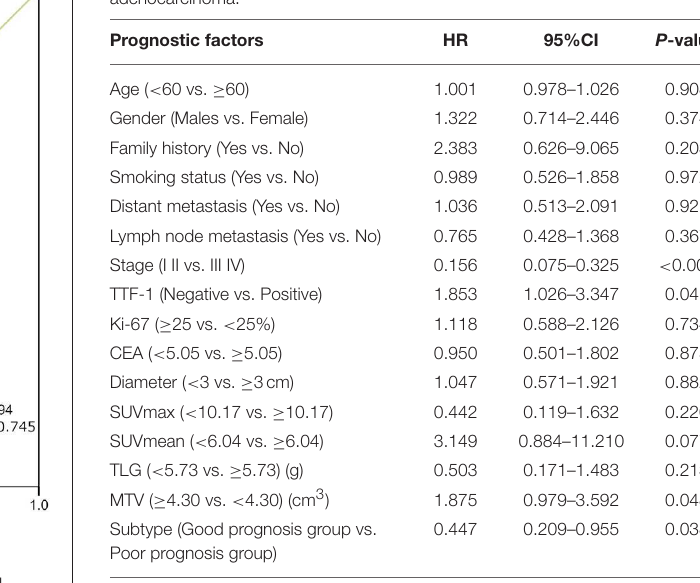
TABLE 5 | The univariate analysis of prognosis in patients with invasive lung adenocarcinoma.